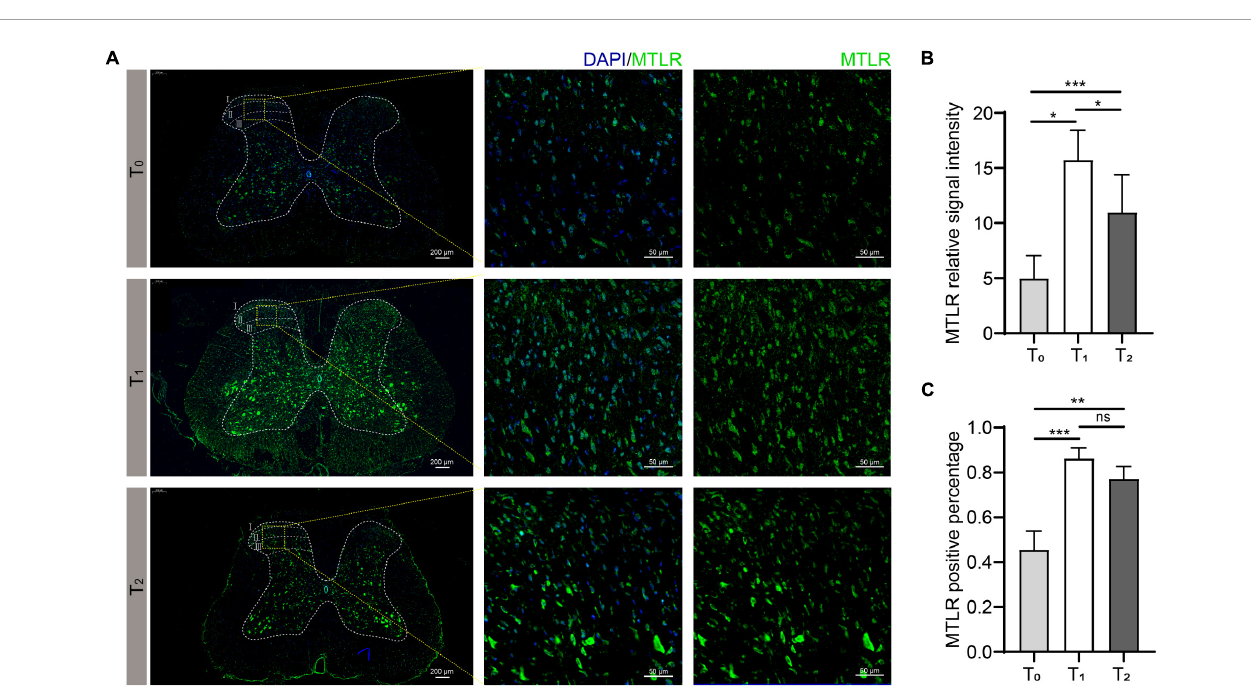
FIGURE3 Motilin receptor (MTLR) fluorescence in the spinal dorsal horn before surgery (T0), 2 h after acute incisional pain (T1), and 24 h after surgery (T2). (A) Immunofluorescence images. Scale bar = 200 µ m/50 µ m. (B) MTLR relative signal intensity. (C) MTLR positive percentage. n = 6 rats/group/time point. ns, not significant; * P < 0.05, ** P < 0.01, and *** P <